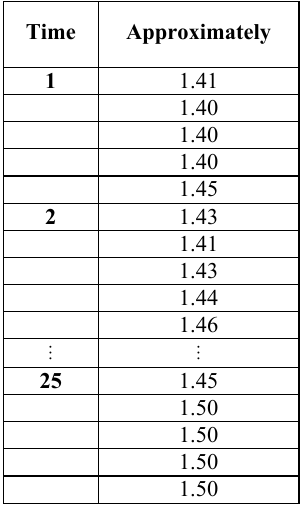
Table 1. The approximate values of inner diameters of natural gas valves.